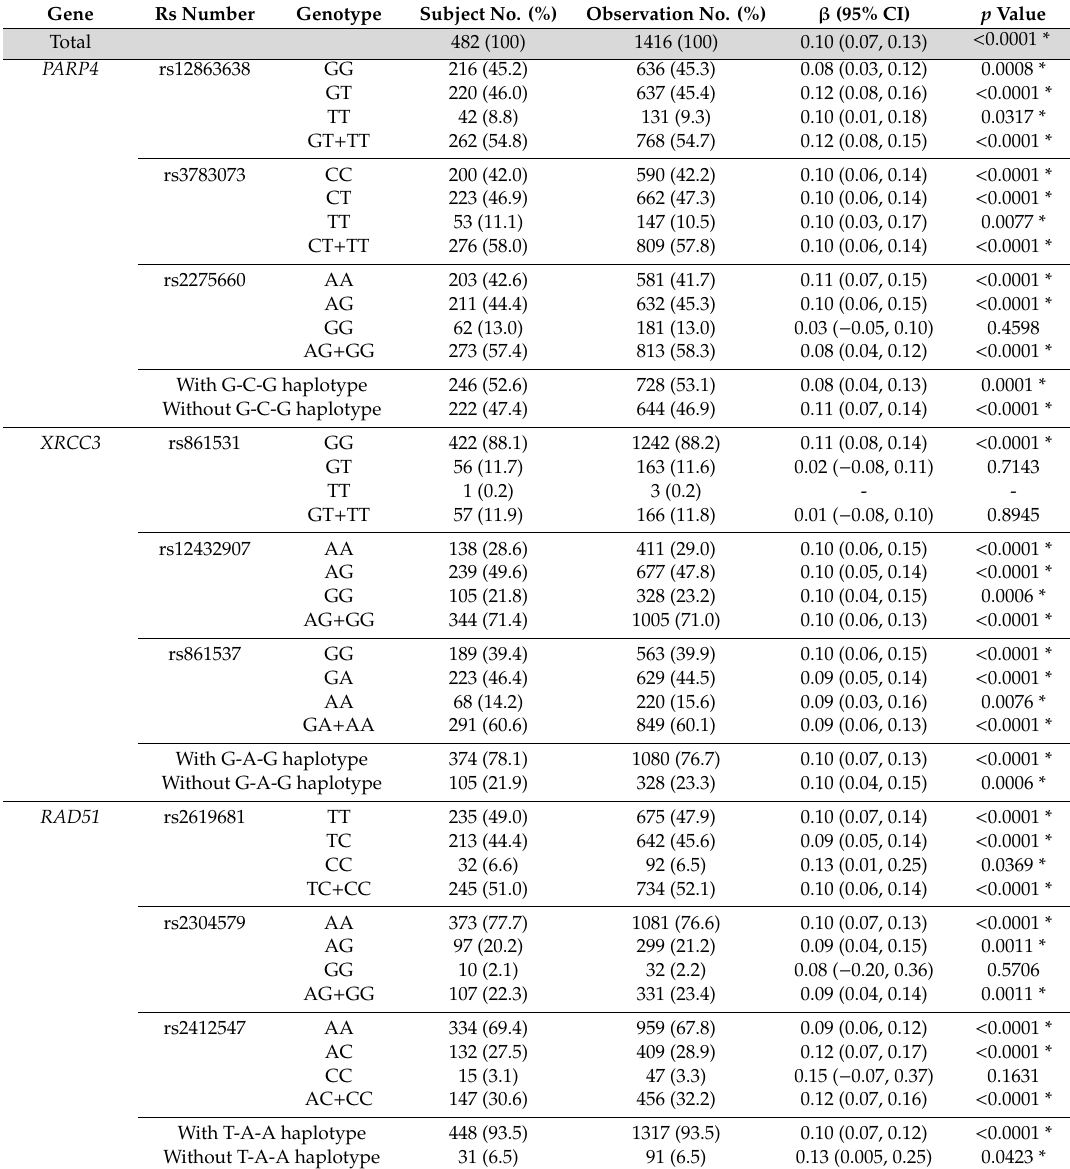
Table 4. The relationships between BPA exposure and oxidative stress by repair gene polymorphisms and combined